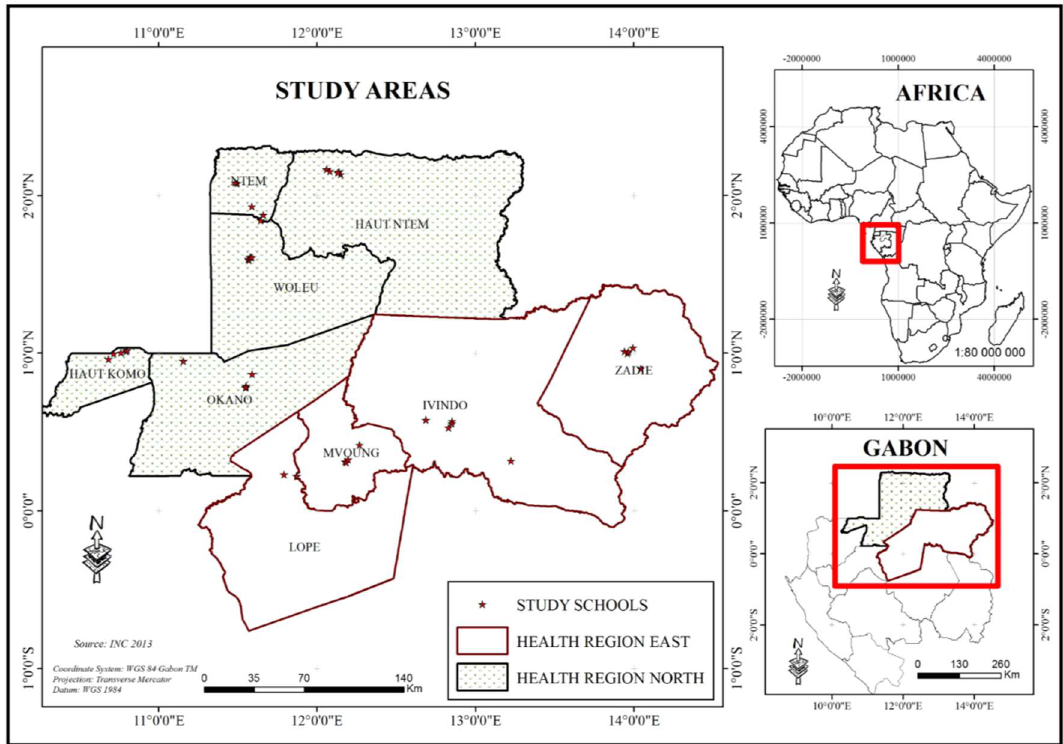
Figure 1. Study area showing the nine health departments surveyed: in the Northen region (gray): Woleu, Ntem, Haut-Ntem, Haut-Okano, Okano and in the Eastern region (white): Ivindo, Lopé, Mvoung, and Zadié.